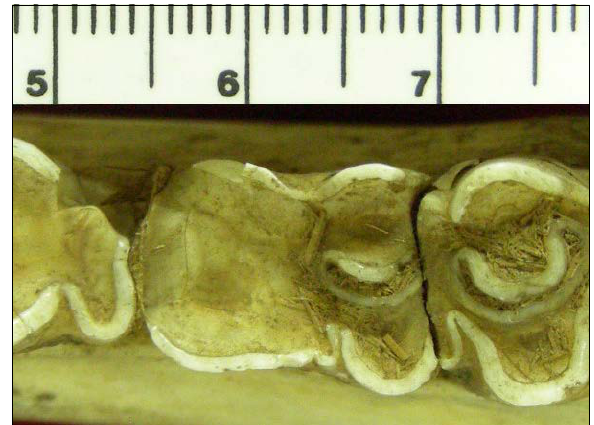
TM 13136, a mandibular first molar from a Hippotragini, Hippotragus niger (sable), that was classified as an Alcelaphini, Alcelaphus buselaphus